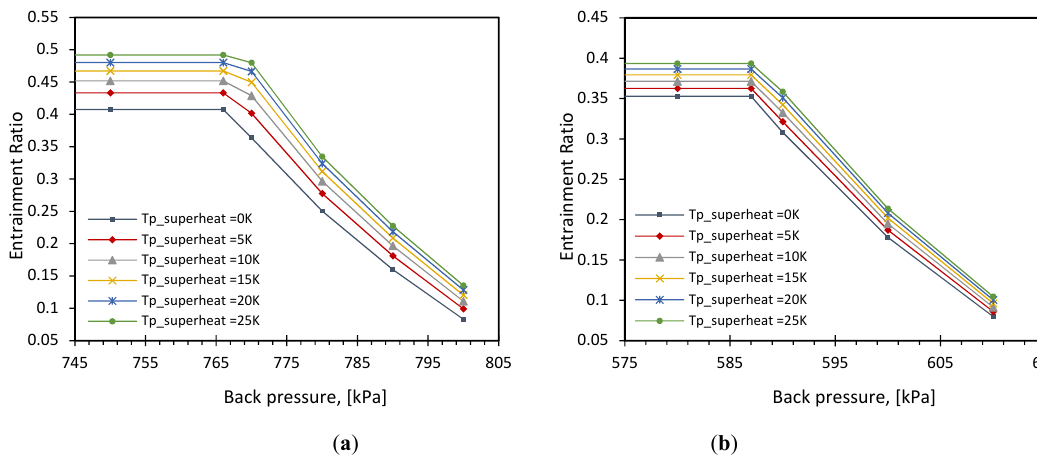
Figure 8. CFD Entrainment ratio vs back pressure for the ejector with superheated primary flow at T s = 6 °C and T p = 80 °C ( a ) R1234yf. ( b ) R1234ze(E).